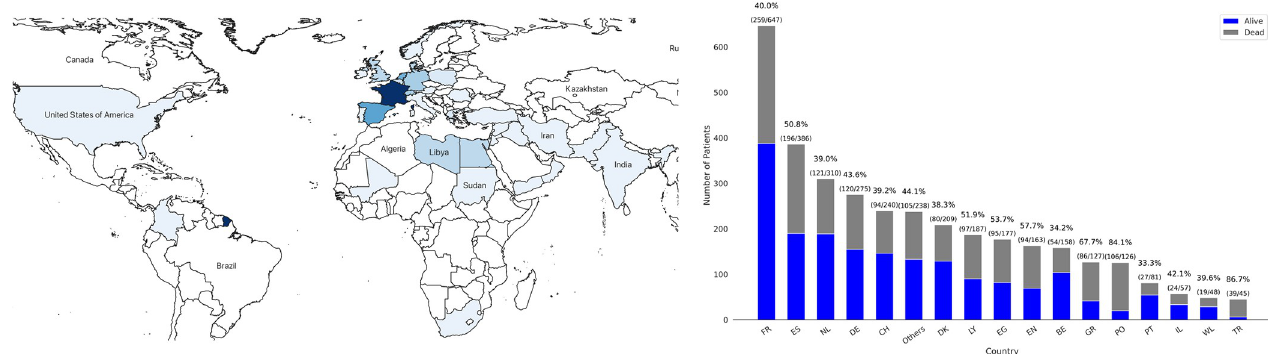
Fig 2. Map of the countries and continents represented in our dataset (left panel). Number of patients for the overall cohort as well as mortality rate per country (right panel). Country and territory abbreviations are detailed in S9 Text. (Map created with QGIS v.3.26 based on data from Natural Earth).